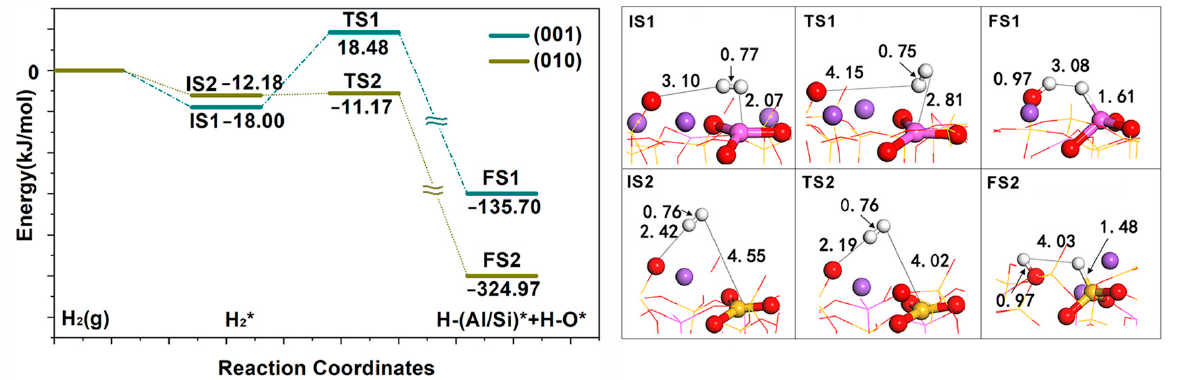
Figure 2. Geometric structures of the transition state intermediates of dissociation reactions of H 2 on the FLP of NaAlSi 3 O 8 (001) and (010) surfaces. * indicates adsorption state, (g) indicates in gas phase state.